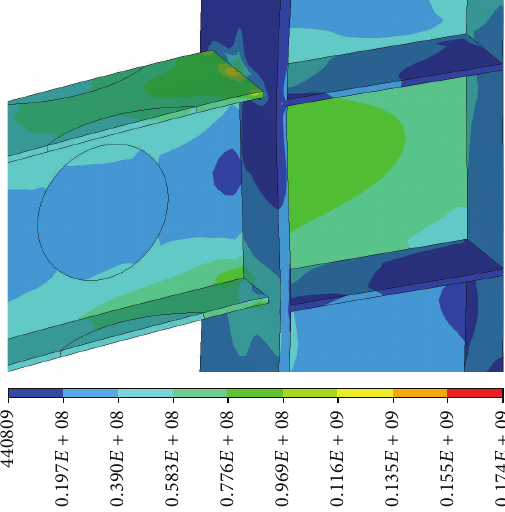
Figure 23: Stress of frame with replaceable connection 2.